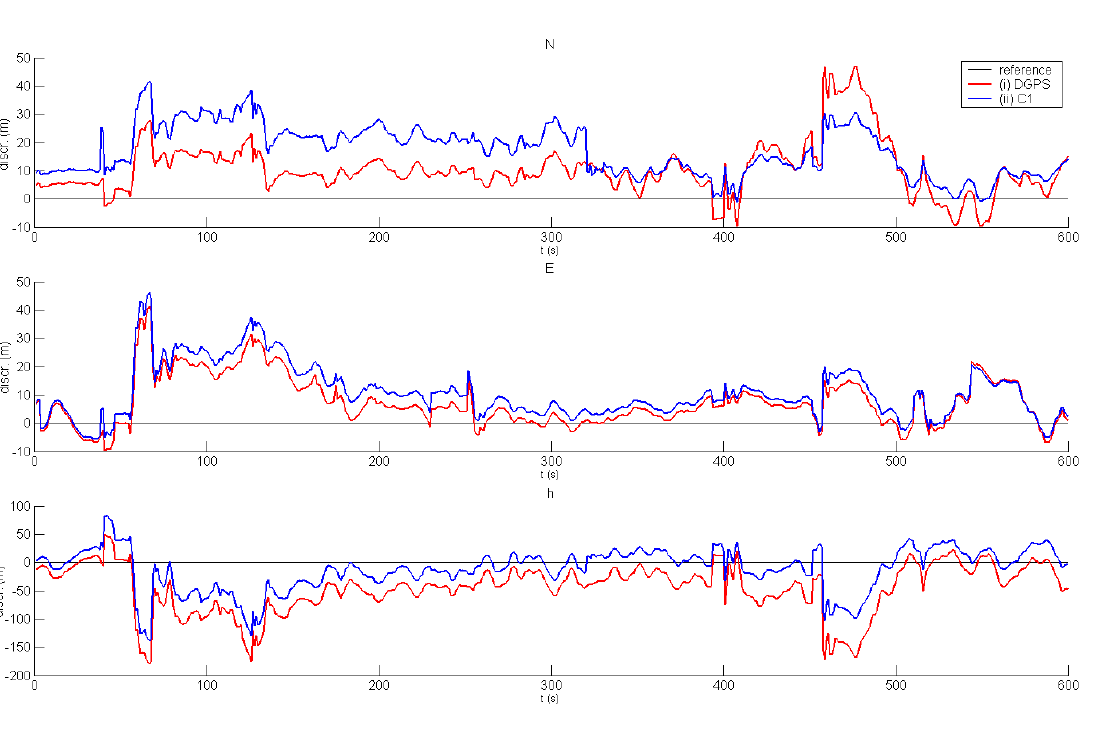
Figure 4. Performance of DGPS under adverse conditions: (i) DGPS positioning; (ii) code-based autonomous positioning.